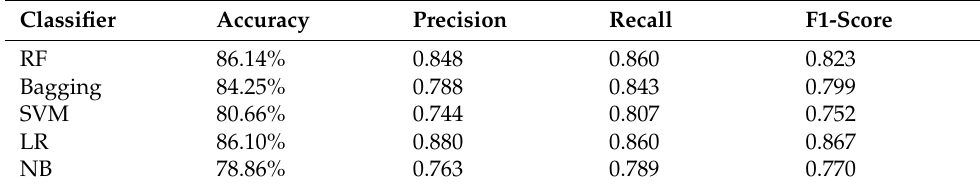
Table 27. Experiments with ML models and Word2Vec and all lexicons on Arab TextBlob sentiments.